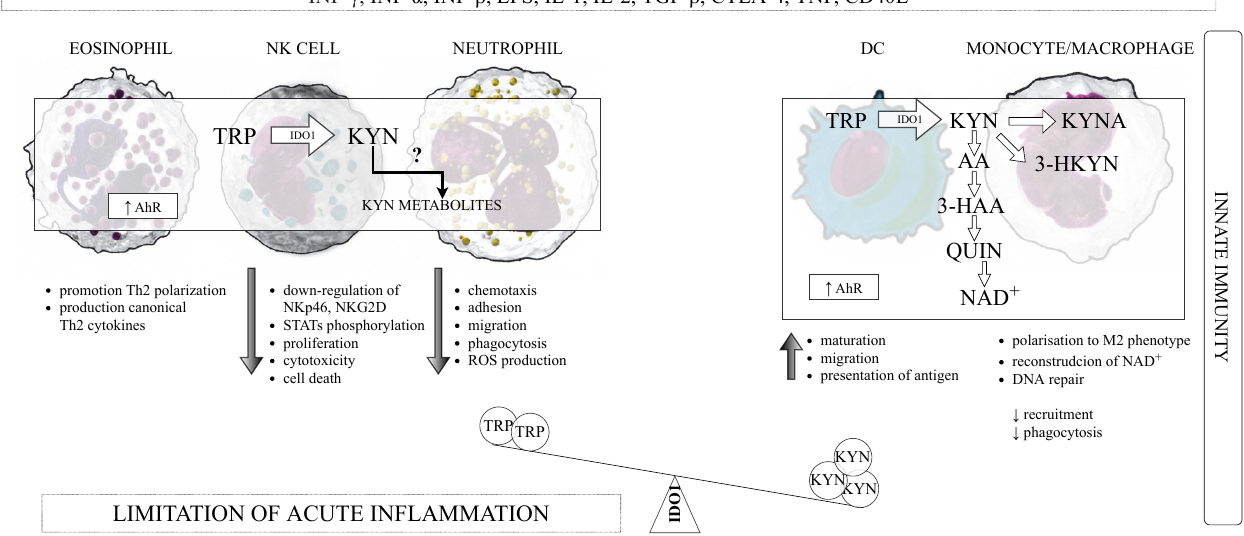
Figure 2. The role of the indoleamine 2,3-dioxygenase 1 (IDO1) and kynurenine pathway metabolites in innate immunity. In acute inflammation, IDO1 is expressed in cells of the innate immunity under the influence of various pro-inflammatory factors. The active IDO1 enzyme transforms local TRP to KYN, and potentially could be transformed into other KP metabolites, depending on the cell type and its expression of downstream enzymes of the KP. Antigen-presenting cells (DC, monocyte, macrophage) are equipped in all enzymes of KP, and especially in these cells, KYN may be further metabolized. Kynurenines derived from IDO1-mediated TRP degradation can activate AhR, which is present in all cells belonging to the innate immunity. Induction of IDO1 expression and activity, as well as the metabolites of KP, have multiple effects on innate immunity. DCs maturation, migration, and antigen presentation are dependent on IDO1 activity. However, IDO1 plays a suppressive role in the immune responses generated by monocyte/macrophages, eosinophils, neutrophils, and NK cells, contributing to the limitation of the local inflammatory state. Abbreviations: IFN- α —interferon α ; IFN- β —interferon β